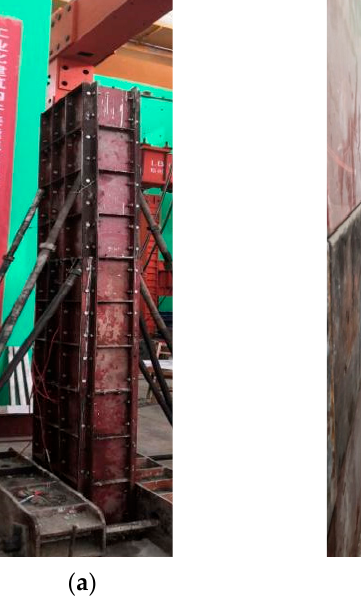
Figure 1. Lateral pressure test arrangement of vertical joint: ( a ) vertical joint formwork; ( b ) arrange- ment of measuring cells (unit: mm); ( c ) casting of